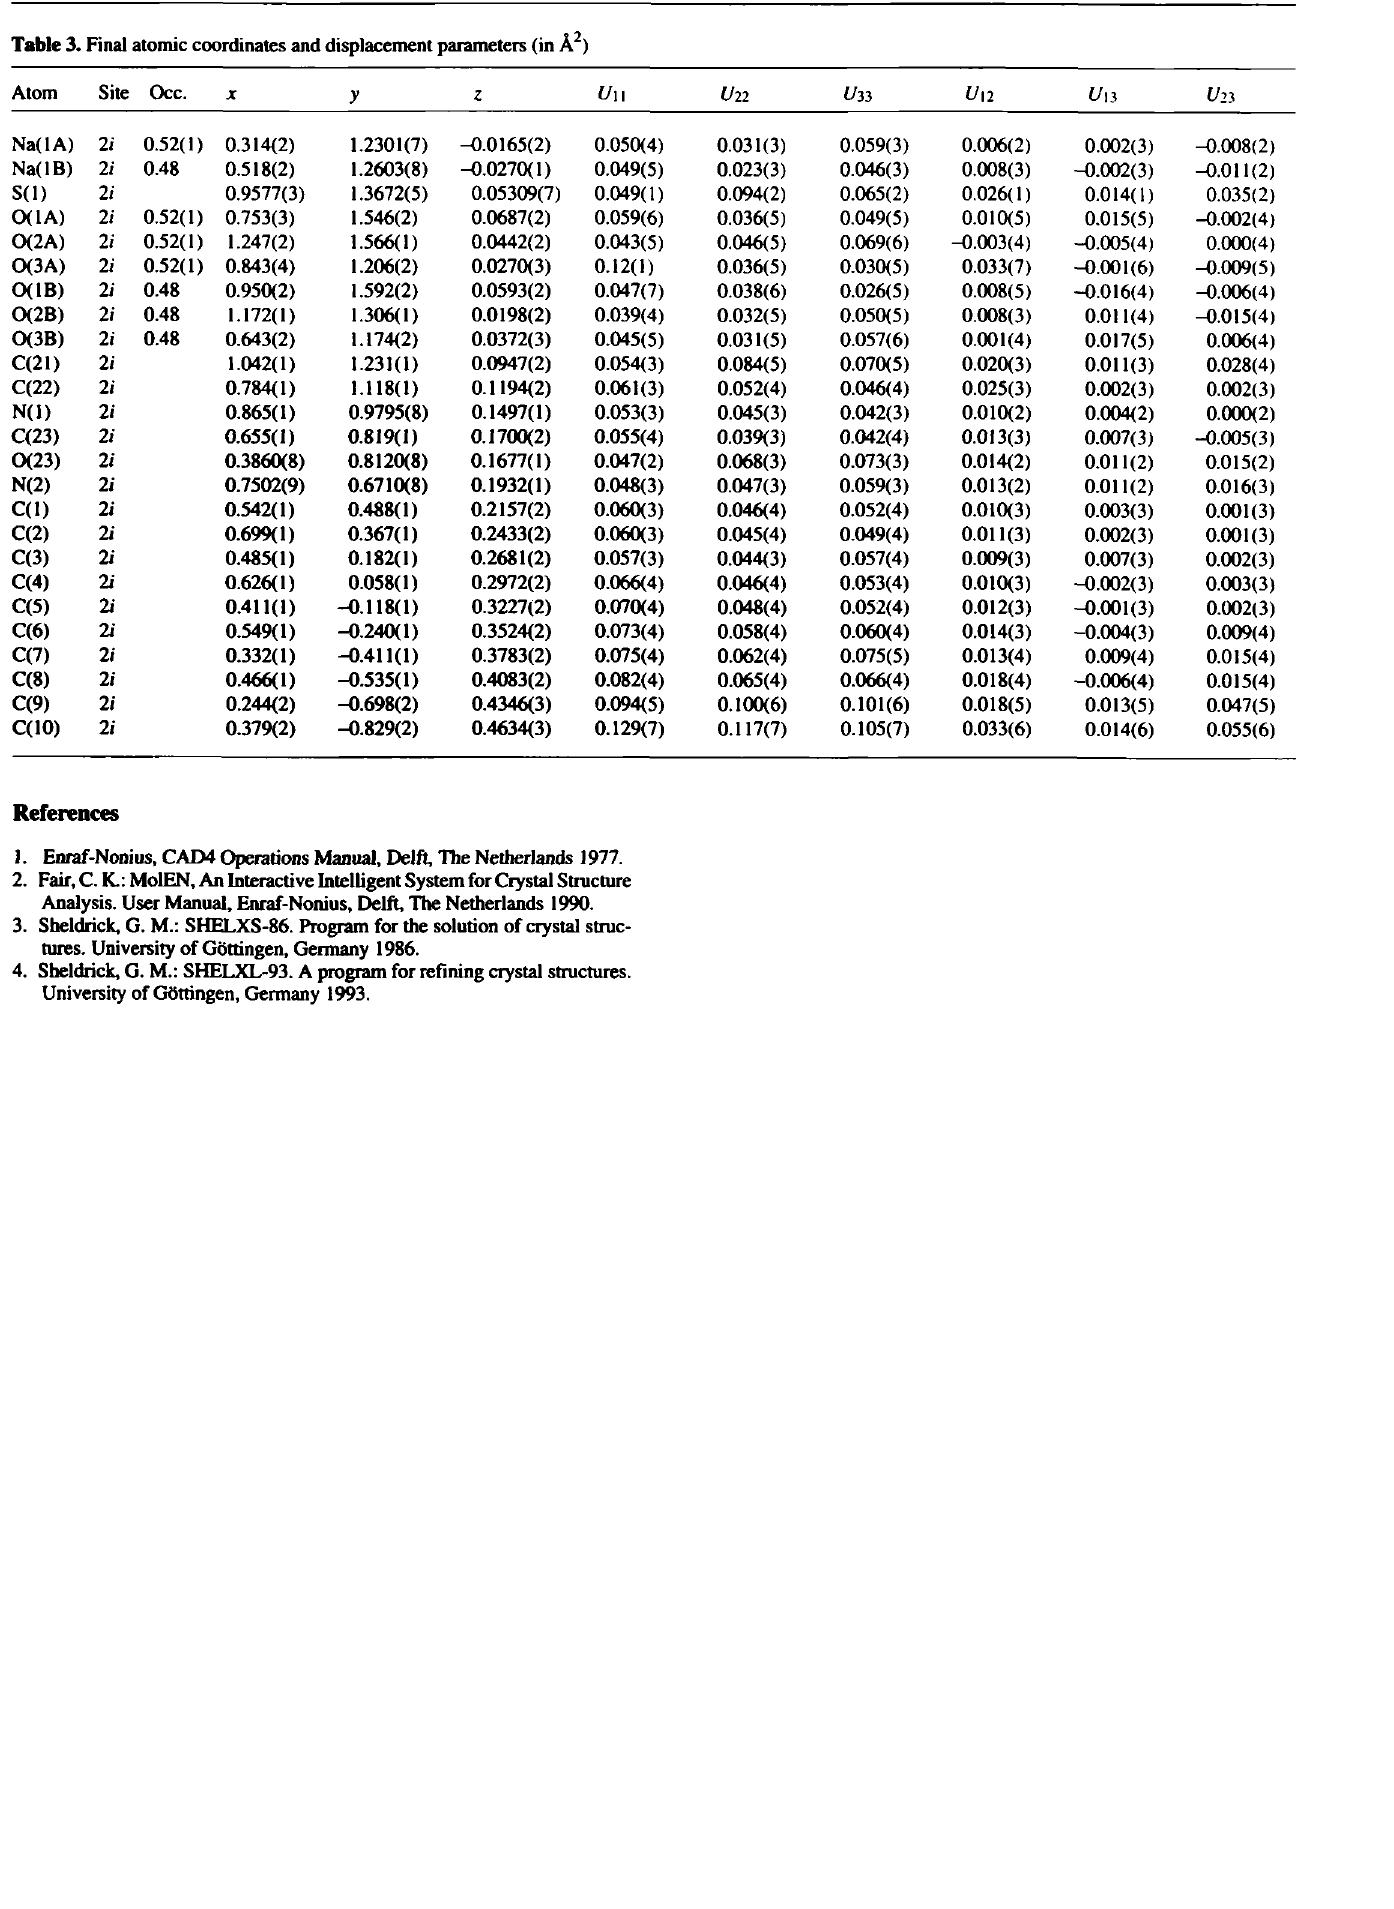
Table 3. Final atomic coordinates and displacement parameters (in Â^) Atom Site